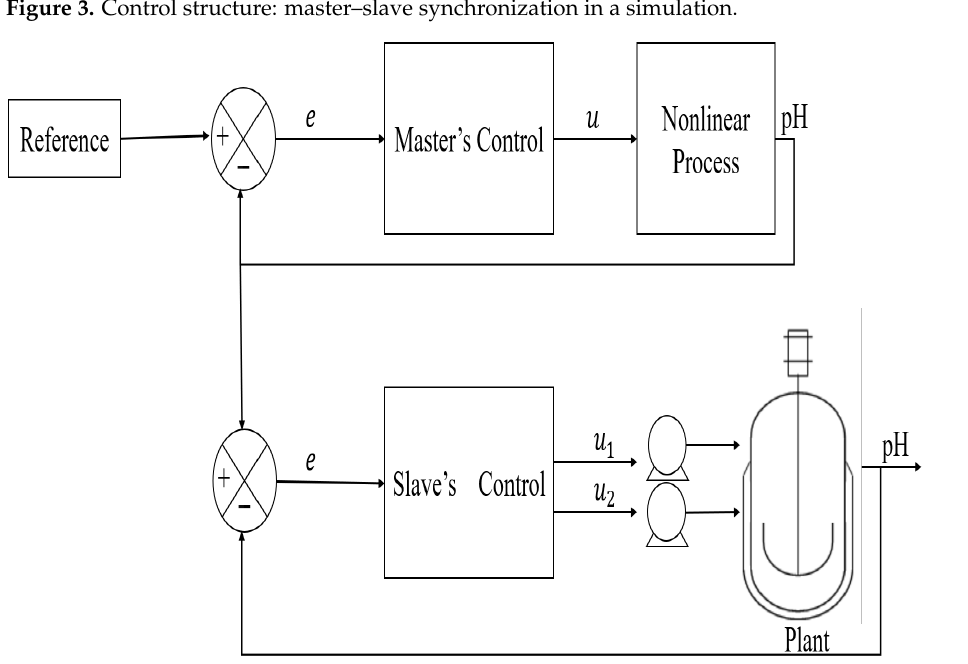
Figure 4. Control structure: master–slave synchronization in a real